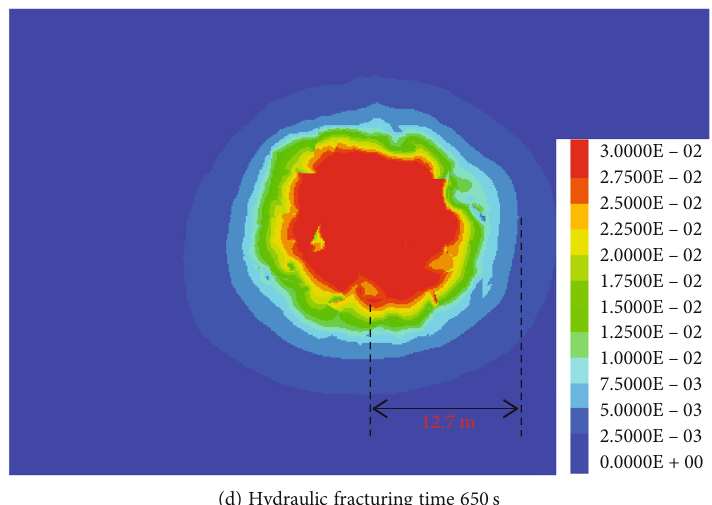
Figure 6: Characteristics of fracturing radius under di ff erent fracturing time (10 m 3